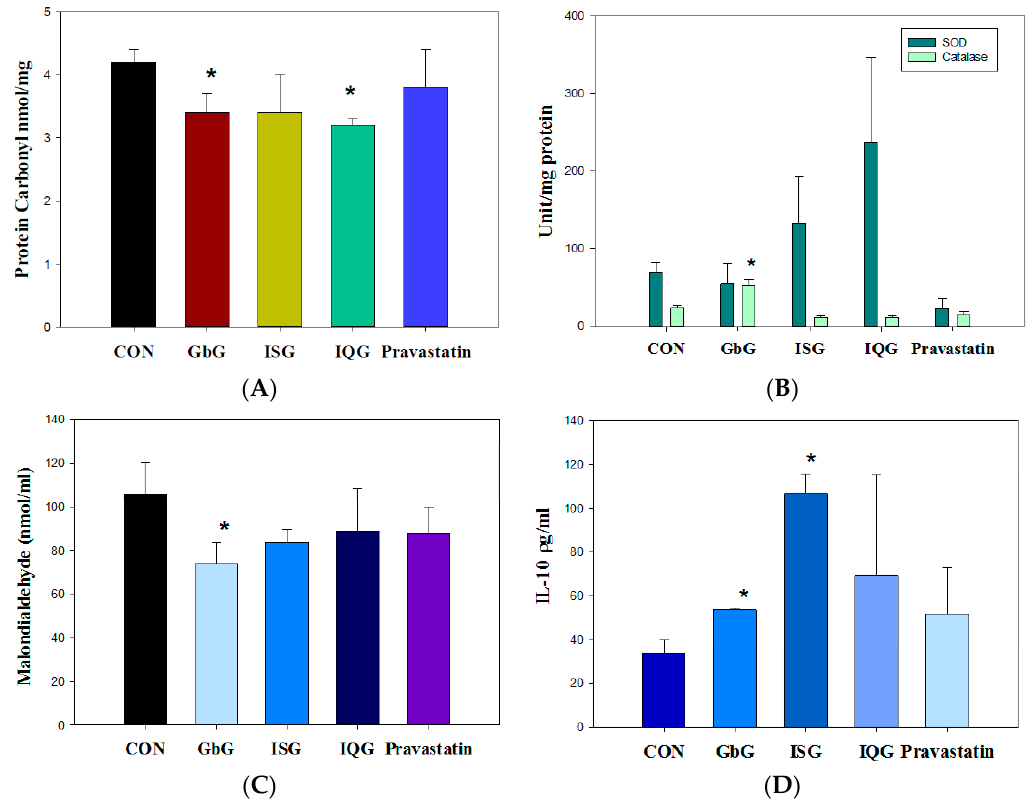
Figure 4. Anti-oxidative effect of some GAG on proteins ( A ) carbonyl, ( B ) Super oxide dismutase (SOD) or catalase content, and on lipids ( C ) malondialdehyde or ( D ) Interleukin-10. (* p <